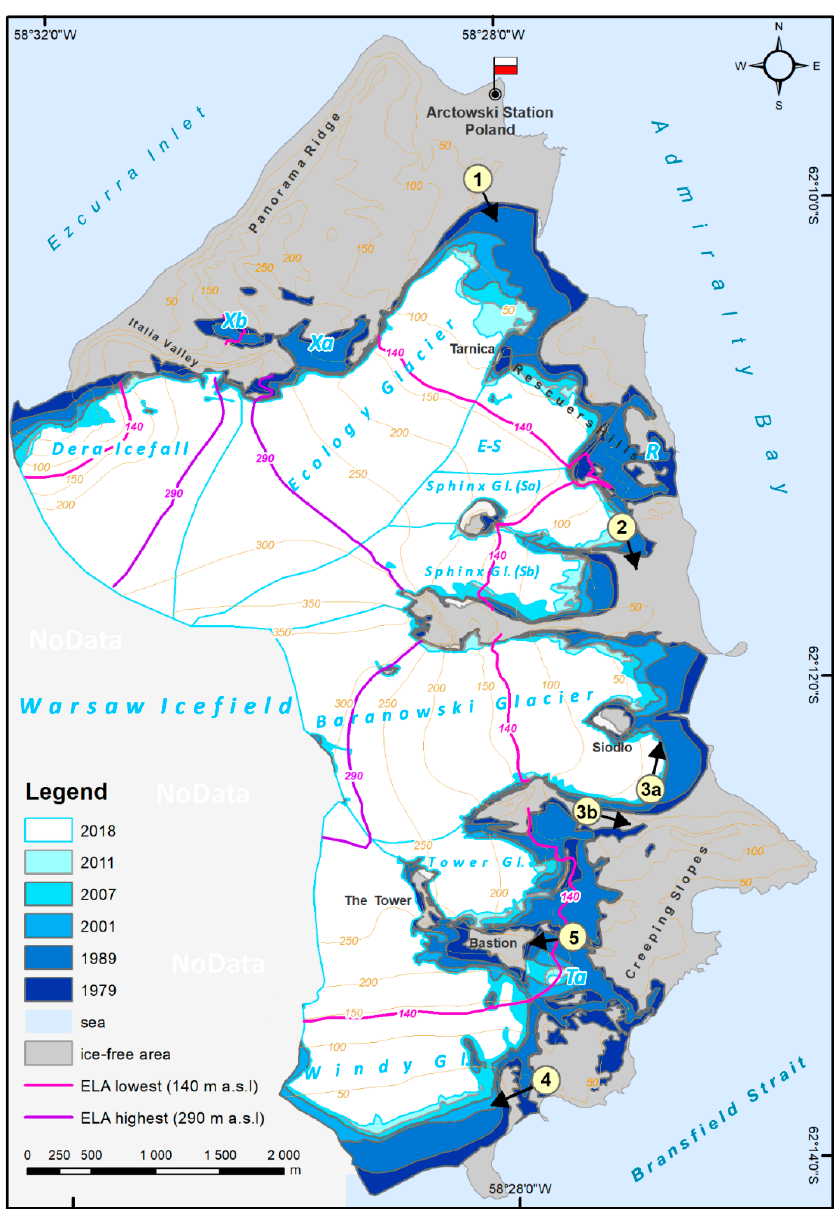
Figure 5. The changes in glacier coverage during periods of 1979–1989, 1989–2001, 2001–2007, 2007–2011, and 2011–2018 in ASPA-128. The altitudes of the lowest (140 m a.s.l.) and the highest (290 m a.s.l.) reported Equilibrium-Lines Altitude (ELA) are marked on the map. Glacier zones: Dera Icefall, Wróbel Glacier (Xa), Wróbel-Italian Glacier (Xb), Ecology Glacier, Ecology-Sphinx (E–S), Rescuers Hills (R), Sphinx Glacier (Sa), Sphinx-Czajkowski Glacier (Sb), Baranowski Glacier, Tower Glacier, Thawing Glacier (Ta), Windy Glacier. The location of the photographs are shown in Appendix A Figures A2–A4 and their directions were marked in the yellow